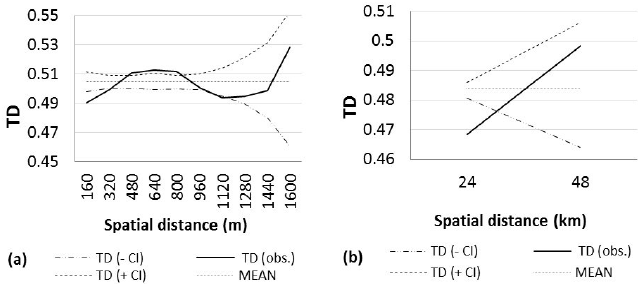
Figure 3. Analysis of large-scale spatial genetic structure in Pinus engelmannii . Analysis of large-scale spatial genetic structure in seven seed stands of P. engelmannii by considering a distance class of size 160 m in the north, and 24 km in the south. Distogram calculated using the mean Tanimoto distance (TD). CI = confidence interval, ( a ) northern stands; ( b ) southern stands.